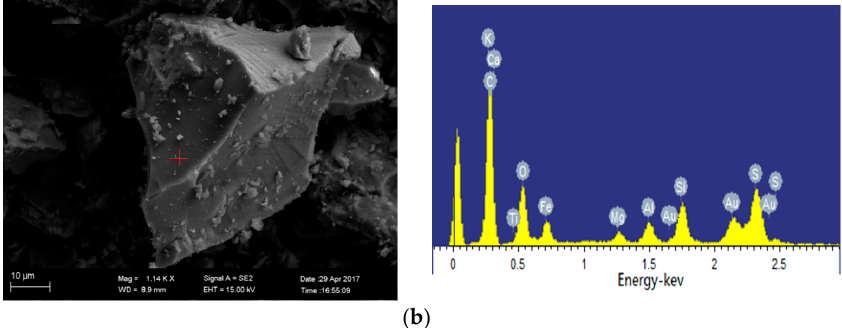
Figure 10. Minerals in oxidation ash of Ulankarma coal (SEM-EDS, secondary electron images). ( a ) 1100 °C; ( b ) 1300 °C.